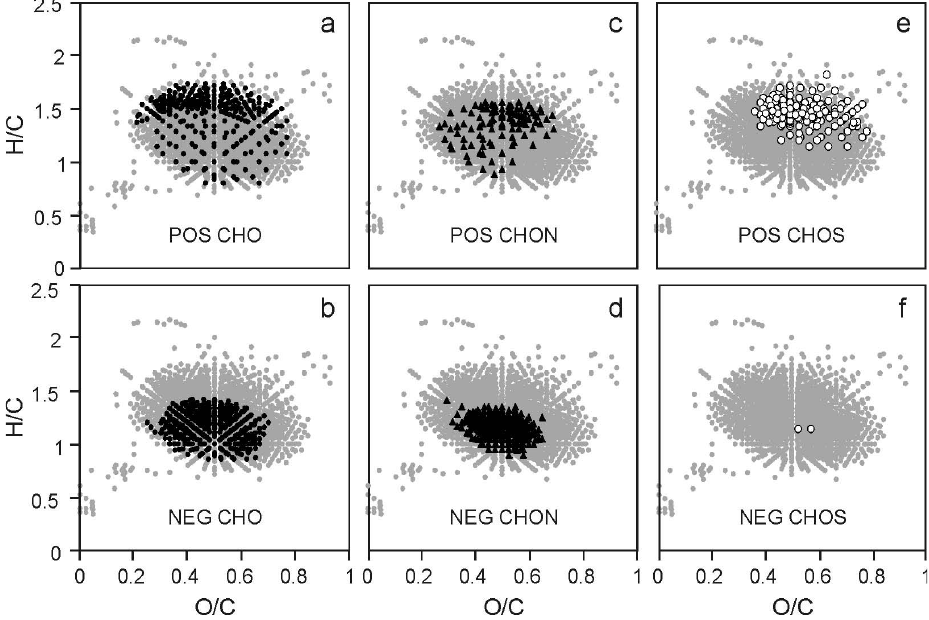
Fig. 7. Van Krevelen diagrams of compounds in eastern Atlantic Ocean SPE-DOM that are significantly correlated with 1 14 C ( p < 0 . 01): (a) positively with CHO compounds; (b) negatively with CHO compounds; (c) positively with CHON compounds; (d) negatively with CHON compounds; (e) positively with CHOS compounds; (f) negatively with CHOS compounds. The grey dots in the background show all compounds found in the majority of Atlantic Ocean water